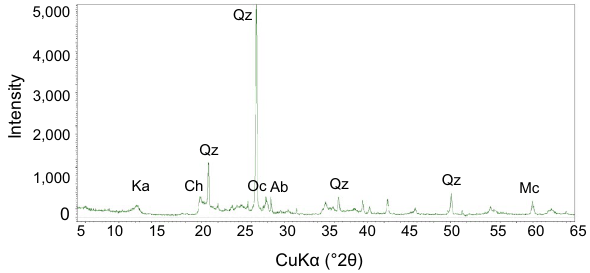
Figure 2. Results of XRD analysis of the clay material used in the manufacture of artificial specimens. Mineral abbreviations: albite (Ab), chlorite (Ch), kaolinite (Ka), microcline (Mc), orthoclase (Oc), and quartz (Qz).